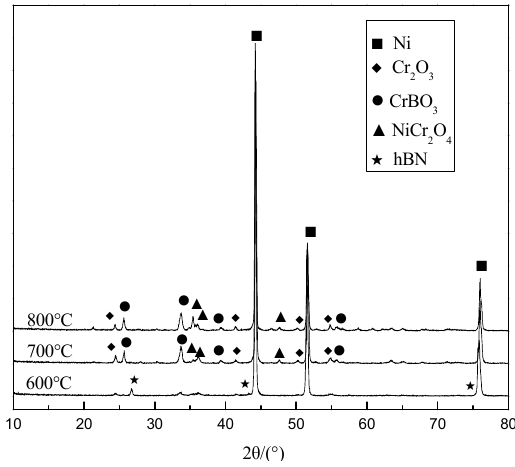
Figure 9. XRD patterns of abrasive at 600, 700, and 800 °C.